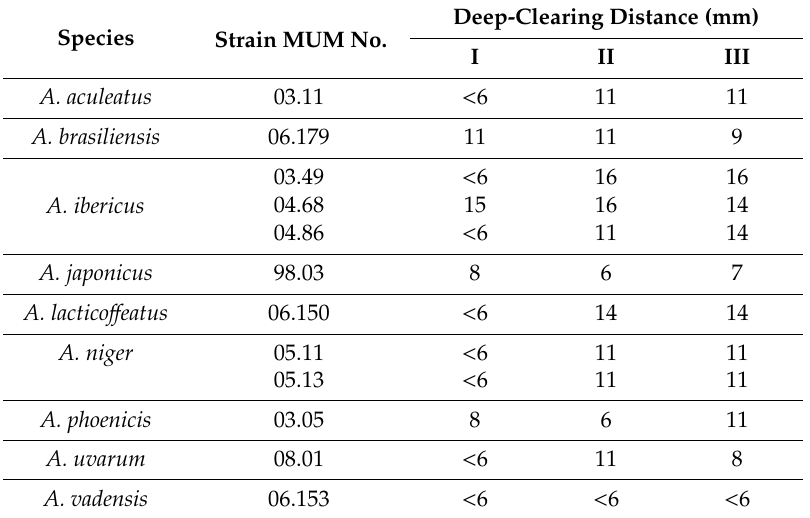
Table 3. Proteolytic activity at day 7 of Aspergillus strains di ff erent preservation time points (before (Time I), after 2 weeks (Time II) and 4 weeks (Time III) of freeze-drying). Species Strain MUM No.